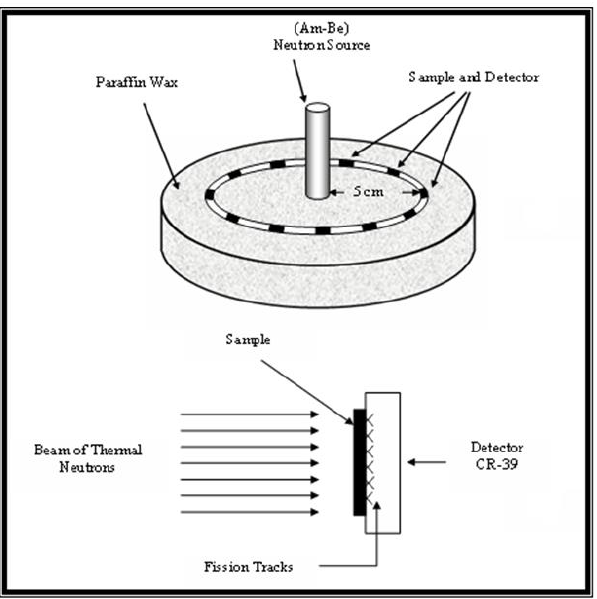
Fig. 3. Water samples and detectors being bombarded with thermal neutrons in front of a neutron source